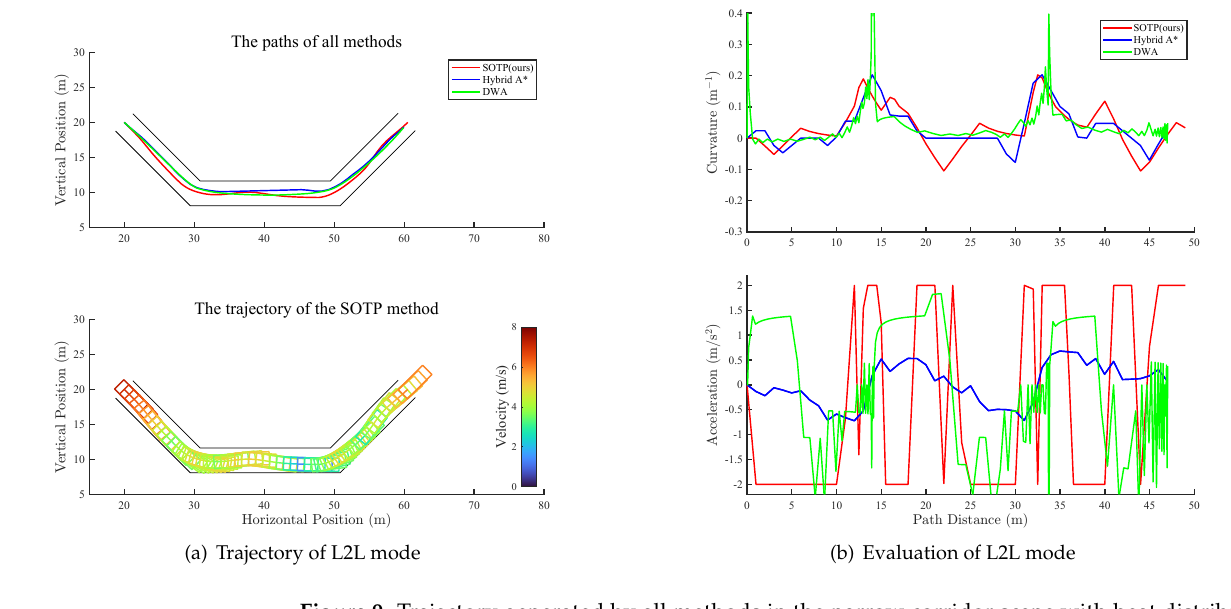
Figure 9. Trajectory generated by all methods in the narrow corridor scene with heat distribution indicating the velocity change. ( a ) the trajectory planned in the L2L mode. ( b ) the curvature and acceleration profile of the trajectories in the L2L mode.